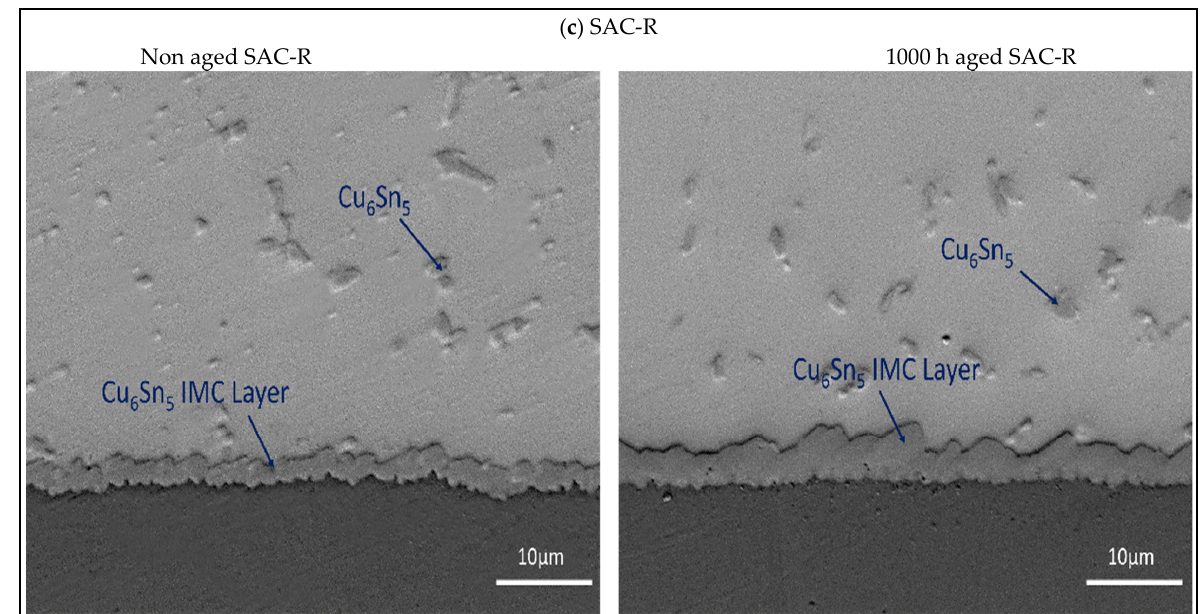
Figure 18. Comparison of aging effect on interface area for ( a ) SAC305, ( b ) SAC-Q, and ( c ) SAC-R. Materials 2023 , 16 , x FOR PEER REVIEW